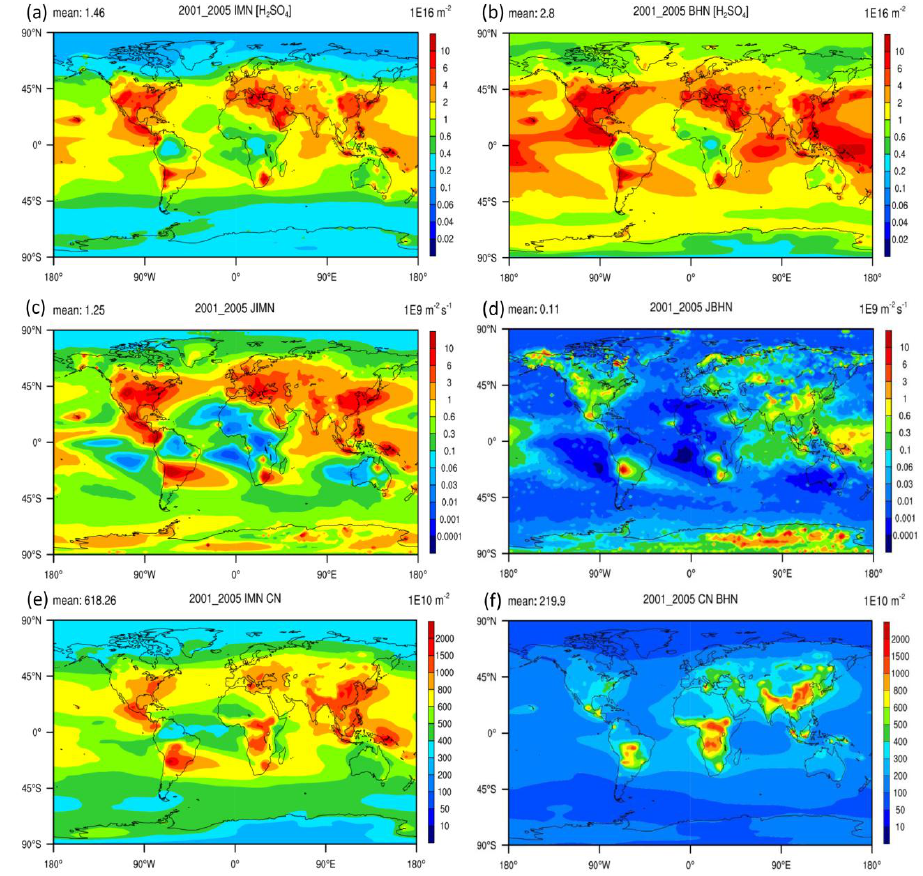
Figure 1. Fig. 1. Annual mean column burdens of H 2 SO 4 vapor, column integrated nucleation rate ( J ), and total condensation nuclei (CN) number burden based on IMN (a, c, e) and BHN (b, d, f)